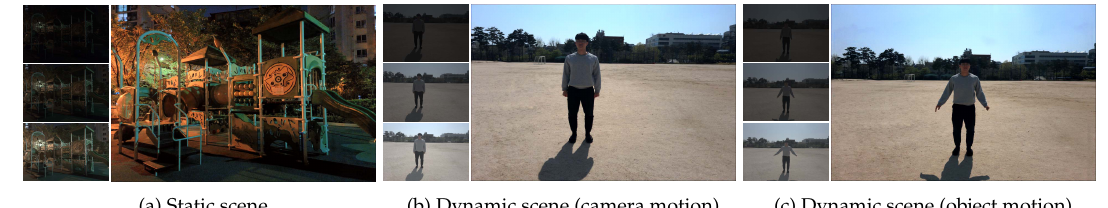
Figure 9. HDR results of using cellphones to capture for both static (camera, object motion) and dynamic scenes. HDR results are aligned to the middle exposure. All LDR images were captured using a Samsung Galaxy S20